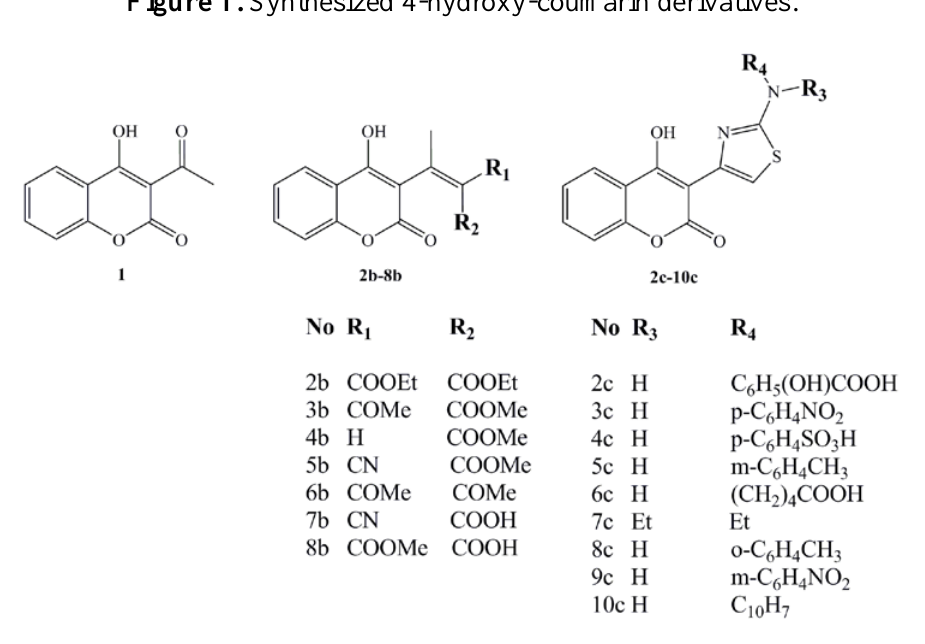
Figure 1. Synthesized 4-hydroxy-coumarin derivatives.